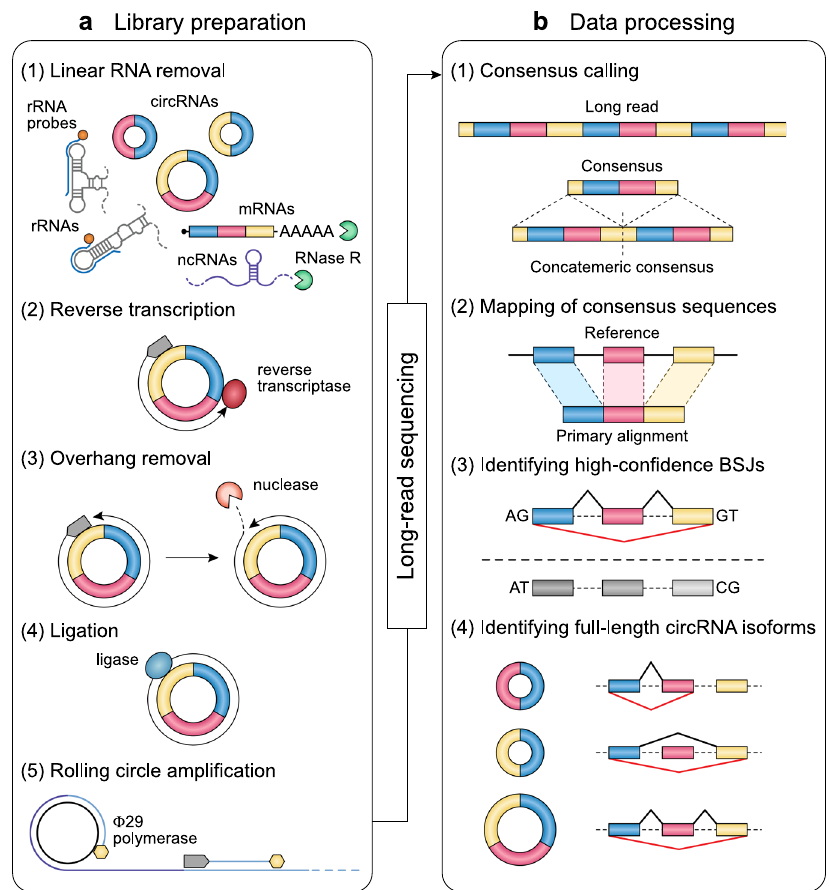
Fig. 1 Overall experimental and computational work fl ow of isoCirc. a Preparation of circular RNA (circRNA) libraries for isoCirc. Extracted total RNAs are subjected to linear RNA removal via ribosomal RNA (rRNA) depletion and RNase R treatment to enrich for circRNAs. The circRNA template is reverse transcribed and digested with nuclease to remove any 5 ′ overhang of the reverse transcription (RT) product. Ligation of the RT product generates the circular cDNA template. Rolling circle ampli fi cation of the circular cDNA template generates the sample for long-read sequencing. ncRNA: noncoding RNA. b Processing of long-read isoCirc sequencing data. In the consensus calling step, tandem repeats are detected from long reads and used to generate consensus sequences. For each read, a concatemer of two copies of the consensus sequence is mapped to the genome to identify the back-splice junction (BSJ) and forward-splice junctions (FSJs) within the circRNA. Alignment records are fi ltered using multiple stringent criteria (e.g., mapping quality, BSJ/FSJ fi delity). In this way, isoCirc enables identi fi cation of high-con fi dence BSJs and full-length circRNA